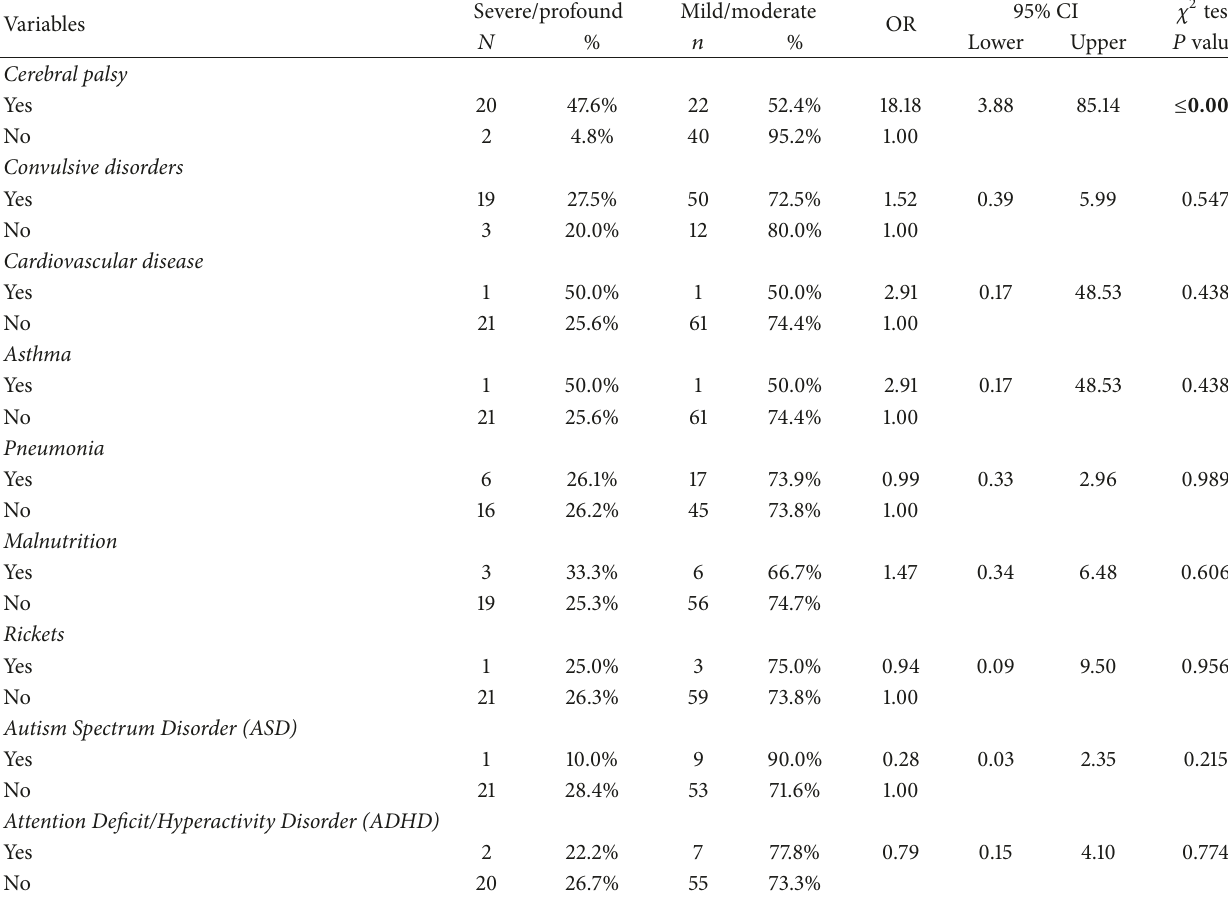
Table 9: Relationship between pre-existing/co-morbid and severity of intellectual